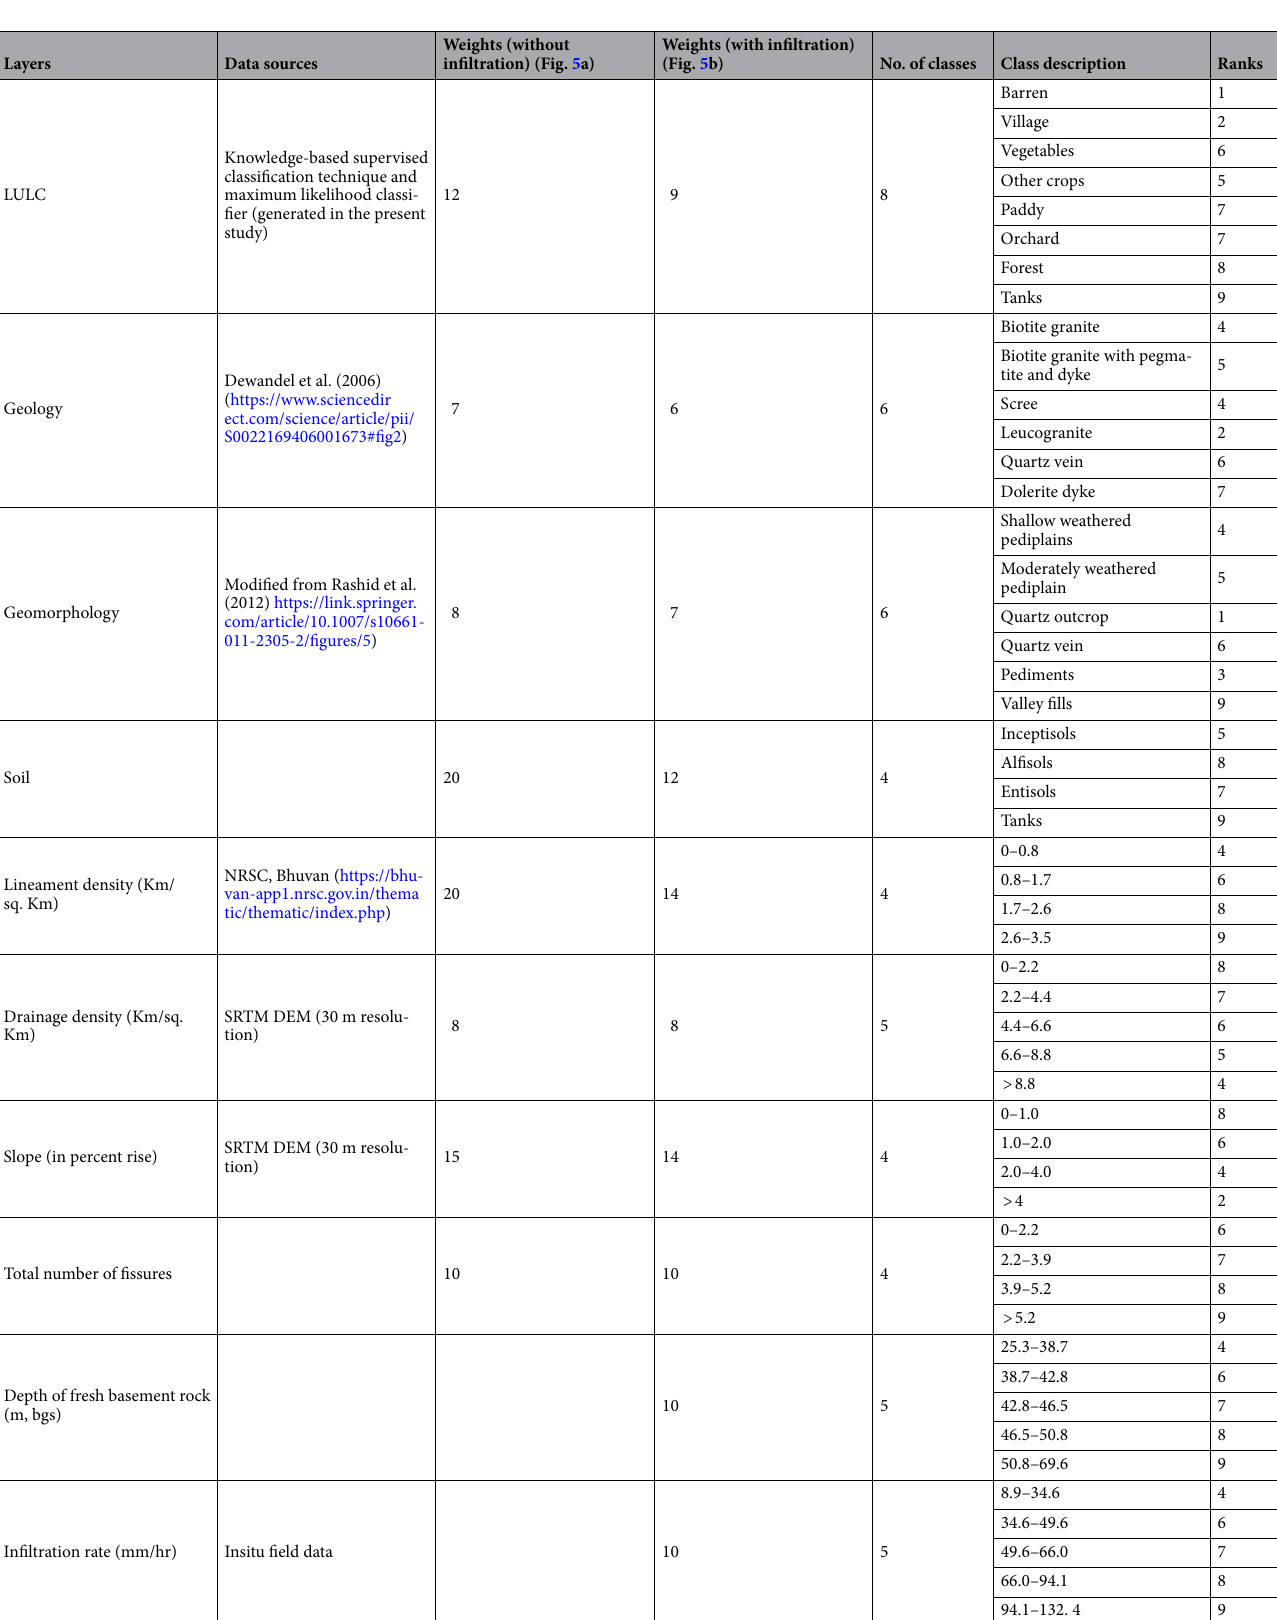
Table 1. Thematic layers used in weighted overlay analysis, their weights and class rank assigned for the preparation of potential recharge zones (Litholog and soil data is provided by Indo-French Centre of Groundwater Research,